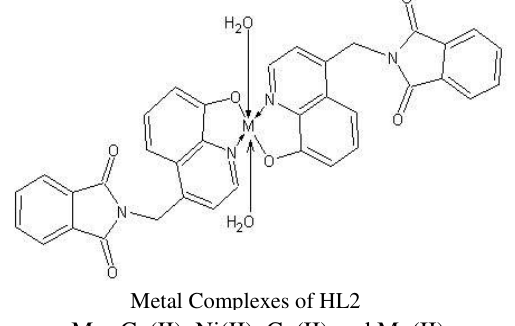
Table 5. Antibacterial and antifungal activity of ligand HL